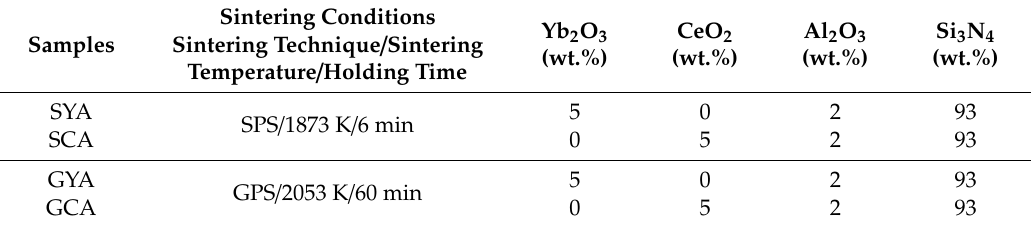
Table 1. Experimental parameters. S—spark plasma sintering (SPS); G—gas pressure sintering